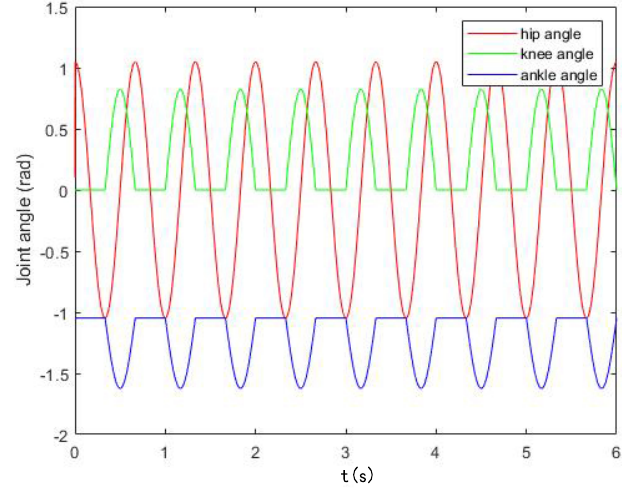
Figure 7. The joint angles of robot.